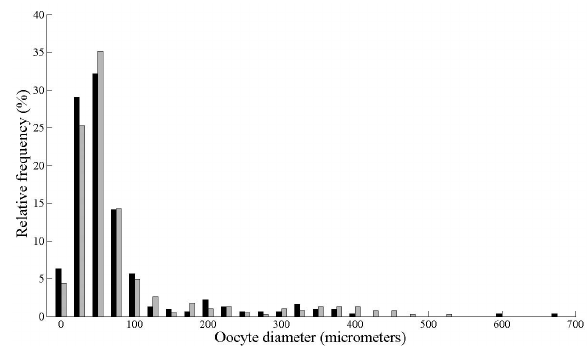
Fig . 1. – Relative frequency distribution of oocyte diameters of P. miles (gray bars) and P. volitans (black bars).